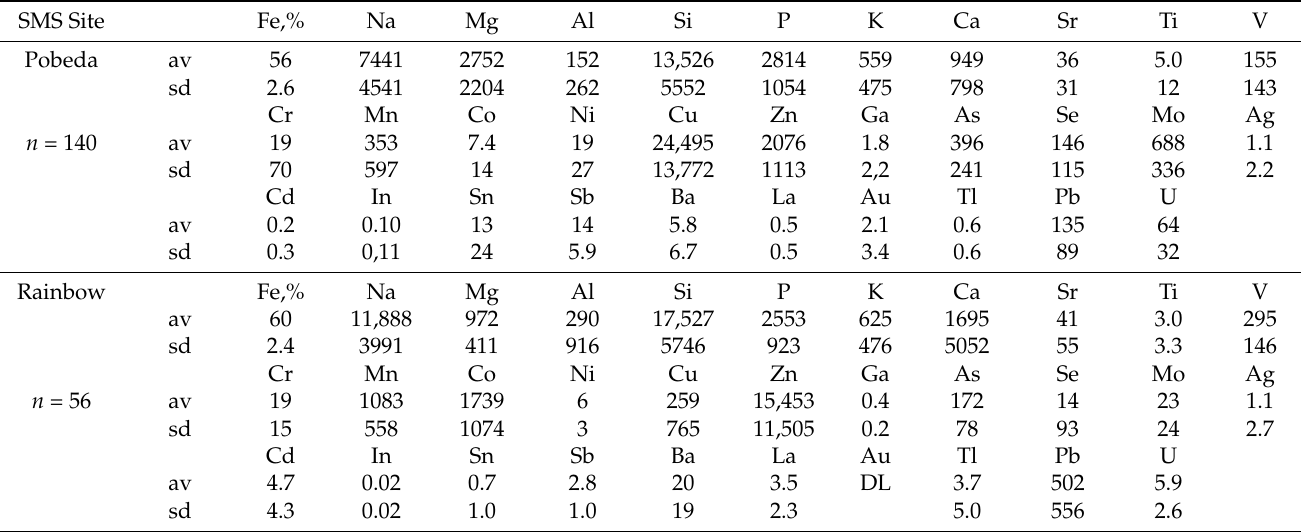
Table 6. Average contents (av) and standard deviation (sd) of IOHs of the ultramafic-hosted